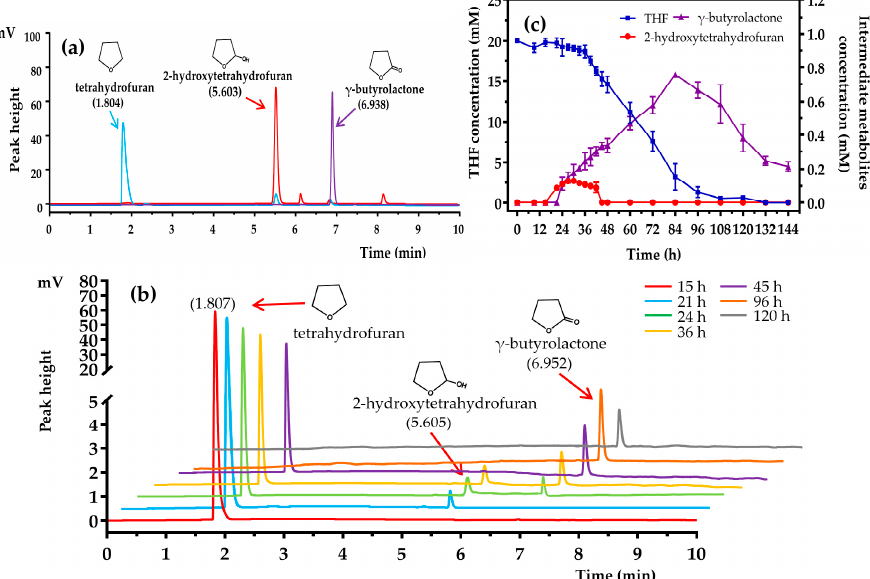
Figure 5. Detection and identification of metabolites during the biodegradation of 20 mM THF by strain ZM01 by GC analyses: ( a ) the retention time of different reference standards, including THF, 2-hydroxytetrahydrofuran, and γ -butyrolactone; ( b ) the detection and identification of the intermediate metabolites 2-hydroxytetrahydrofuran and γ -butyrolactone during the degradation of 20 mM THF by GC; and ( c ) the concentration changes of 2-hydroxytetrahydrofuran and γ -butyrolactone during the degradation of 20 mM THF by strain ZM01.